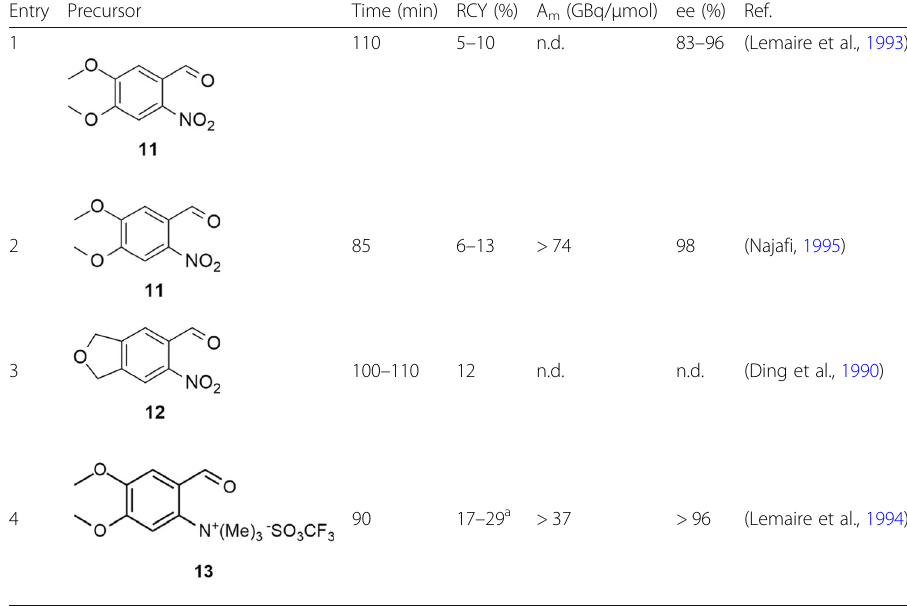
Table 1 Synthesis of 6-[ 18 F]FDOPA 1 starting from different precursors using chiral auxiliaries Entry